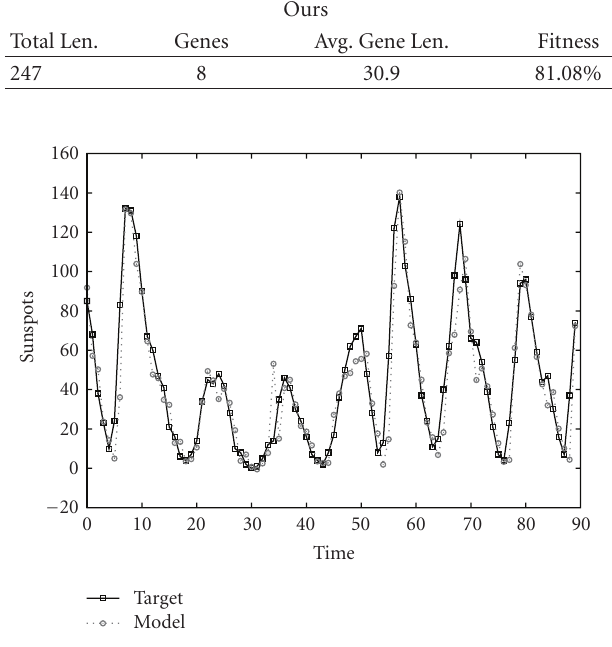
Figure 11: Symbolic regression Experiment 5: Target versus Model.